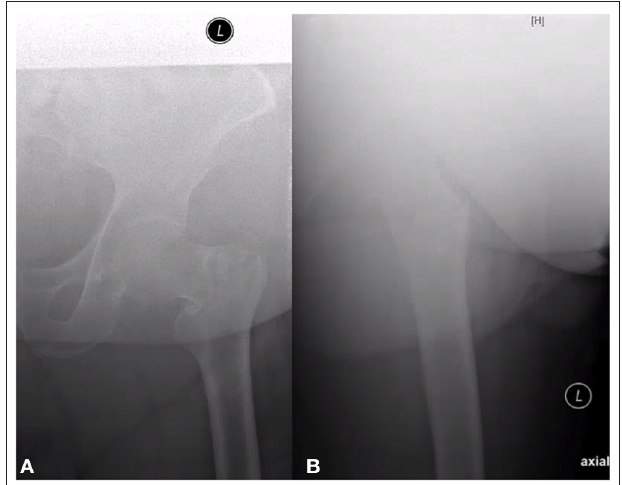
FIGURE 1 | Ap (A) and axial (B) view of an intertrochanteric A1 fracture on the left side. Even with digital filter, the lateral view is not assessable due to obesity.